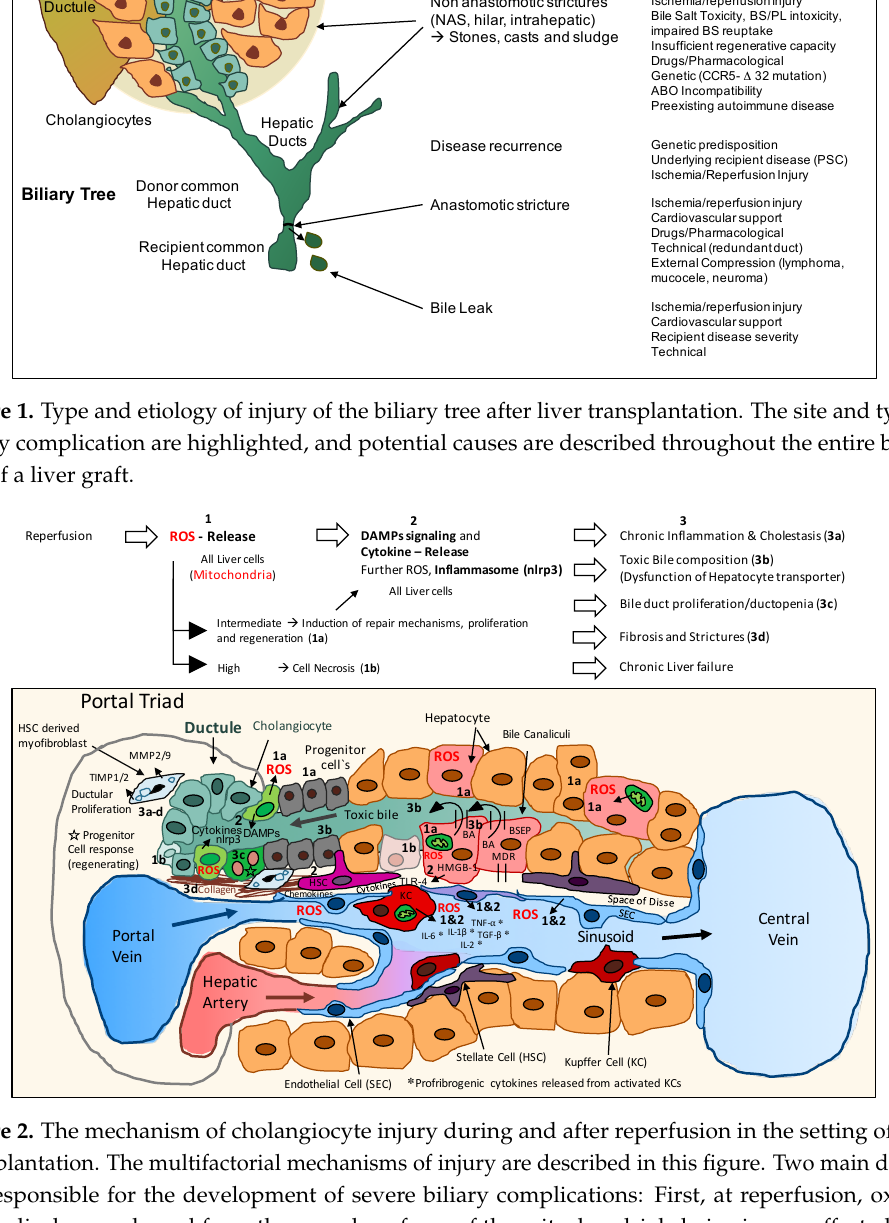
Figure 2. The mechanism of cholangiocyte injury during and after reperfusion in the setting of liver transplantation. The multifactorial mechanisms of injury are described in this figure. Two main drivers are responsible for the development of severe biliary complications: First, at reperfusion, oxygen free radicals are released from the complex of one of the mitochondrial chains in any affected cells, including hepatocytes and cholangiocytes (1). Secondly, the initial oxidative hit triggers downstream inflammation (2) and further aggravation with an ultimate chronic inflammatory status (3). Depending on the liver quality and the amount of graft injury in the donor and during preservation, ATP-dependent bile acid transporters have already an impaired function, which leads to higher vulnerability against toxic bile salts. Such a combination of injuries will likewise lead to an impaired ability to facilitate regeneration of hepatocytes and cholangiocytes (3). BA, Biliary acid; BSEP, Bile salt export pump; MDR, multidrug